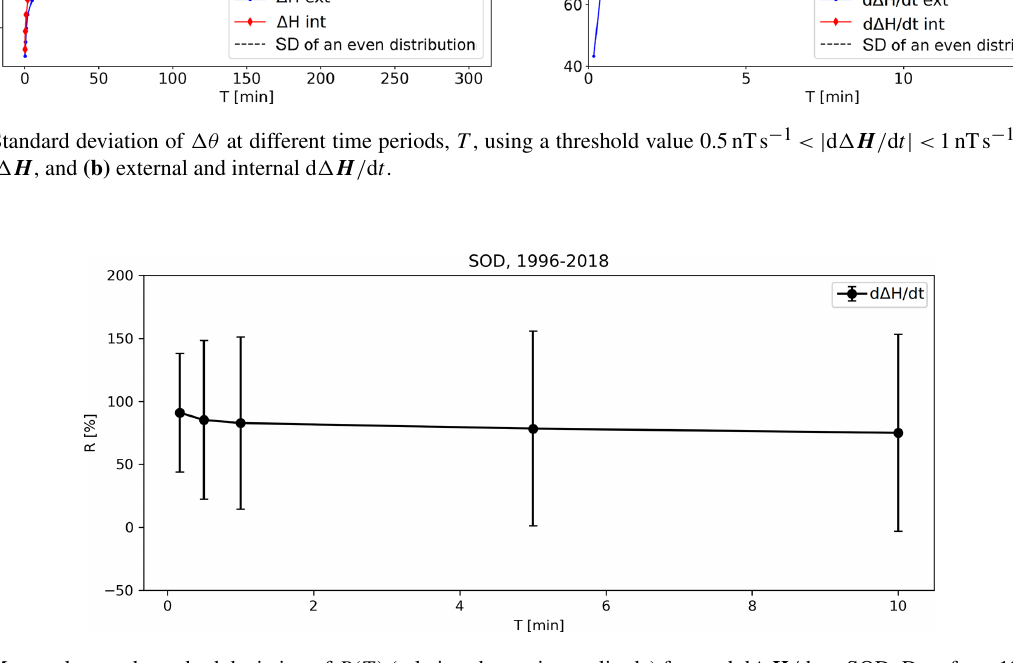
Figure B3. Mean values and standard deviation of R ( T ) (relative change in amplitude) for total d (cid:49) H / d t at SOD. Data from 1996–2018 and T = 10s,